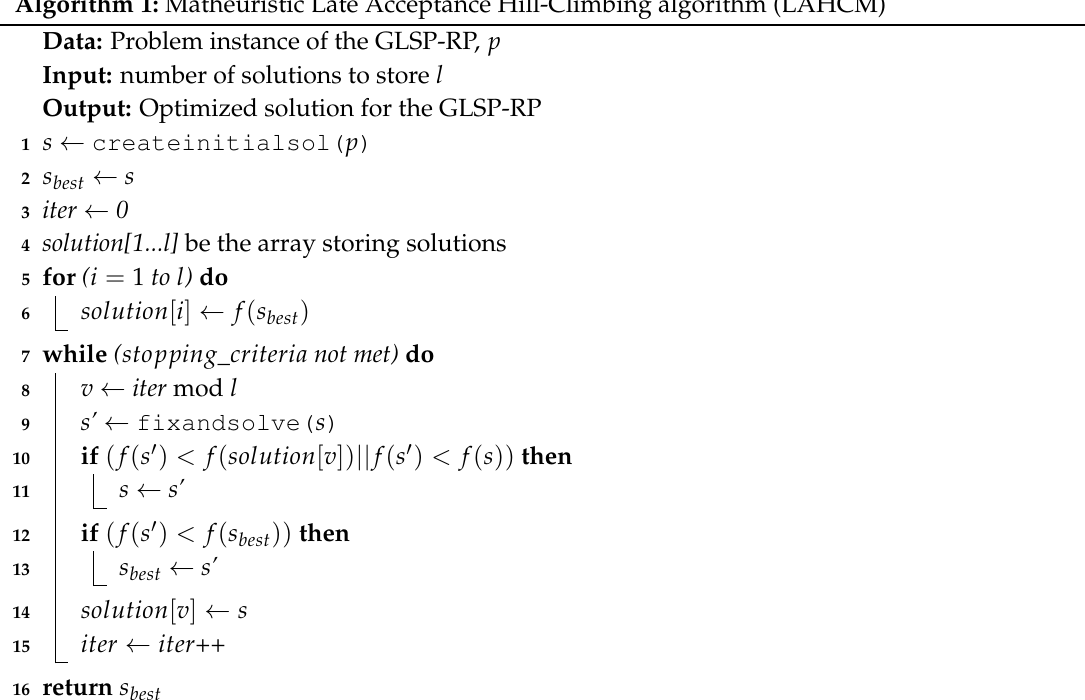
Algorithm 1: Matheuristic Late Acceptance Hill-Climbing algorithm